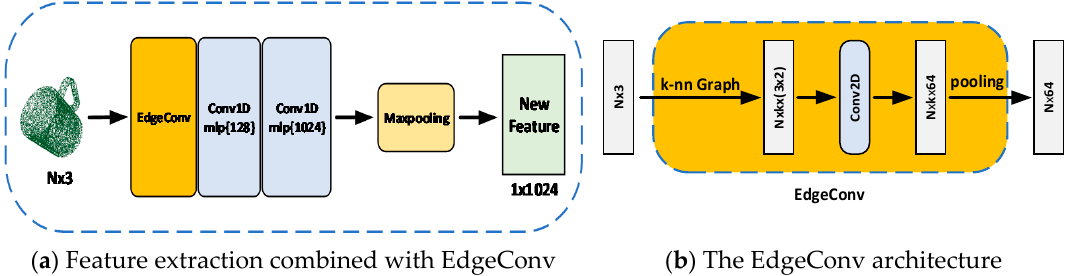
Figure 3. Improved state-embedding module.